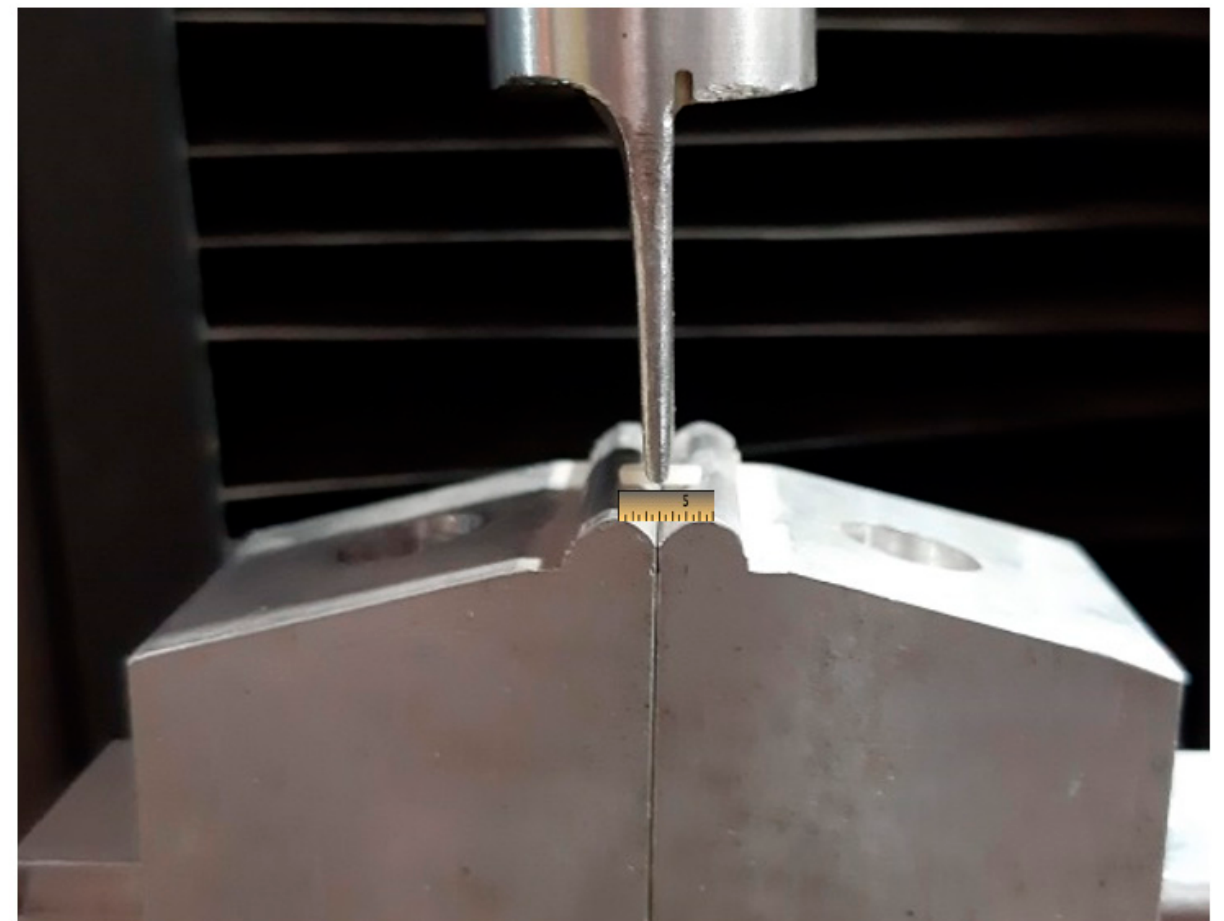
Figure 2. Measurement of microflexural strength with the universal testing machine. The dimen- sions of the resin composite block were as follows: 6 mm long, 1 mm deep, and 2 mm wide.